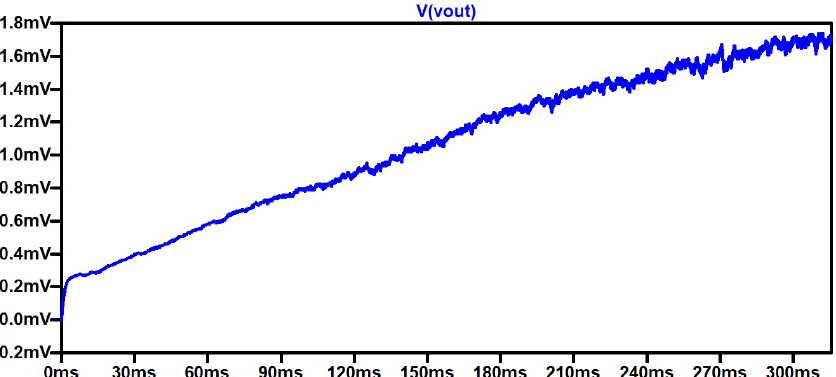
Figure 18. The output-voltage response of the circuit with Si-MOSFET-based switch and RLC Load.